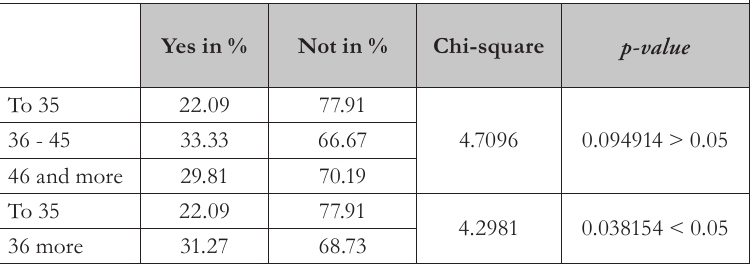
Table 4 Comparison of Pearson chi-square calculations among the chosen age groups in rela - tion to the interest rate risk Ability to protect the firm against the change of interest rate Yes in % Not in % Chi-square p-value To